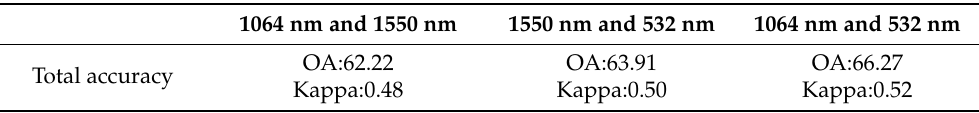
Table 4. Classification results by the random forest